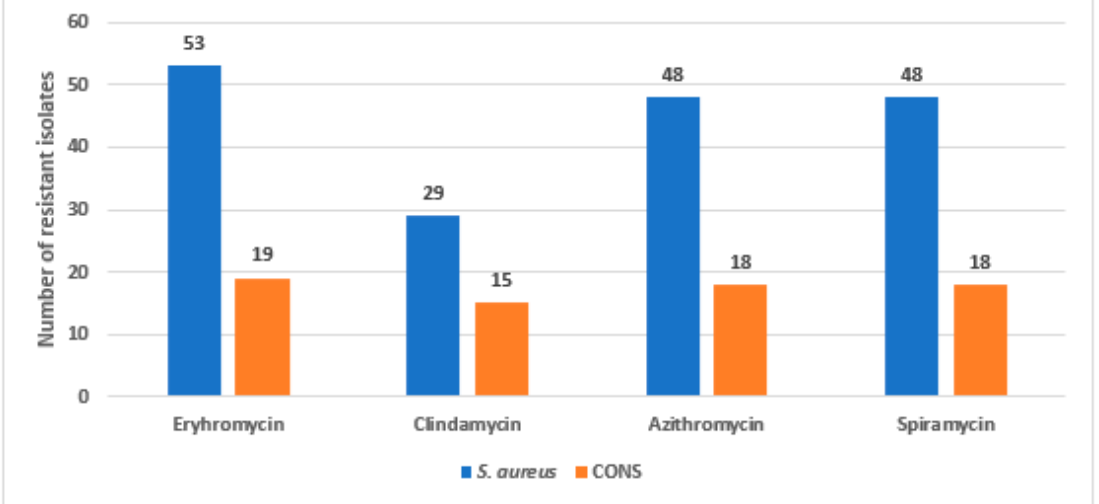
Figure 1. The sensitivity of the resistant Staphylococcus isolates (n = 72) against the tested antibiotics.